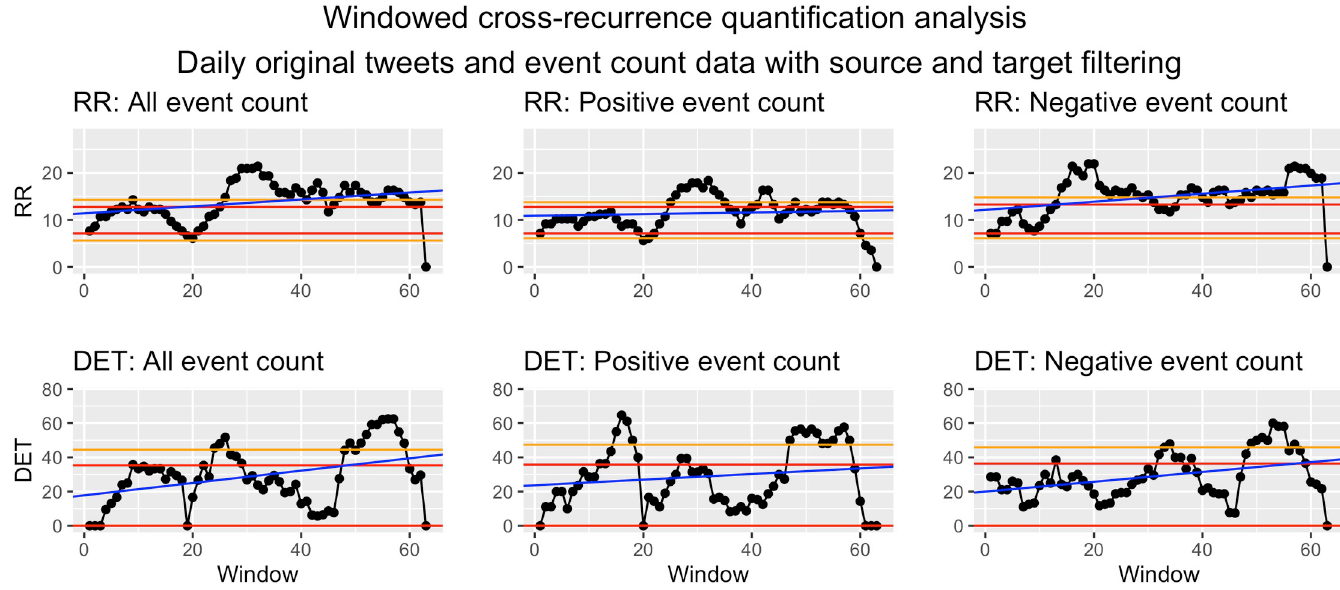
Fig 14. Windowed CRQA for daily original tweets and event counts from source-target filtered data.